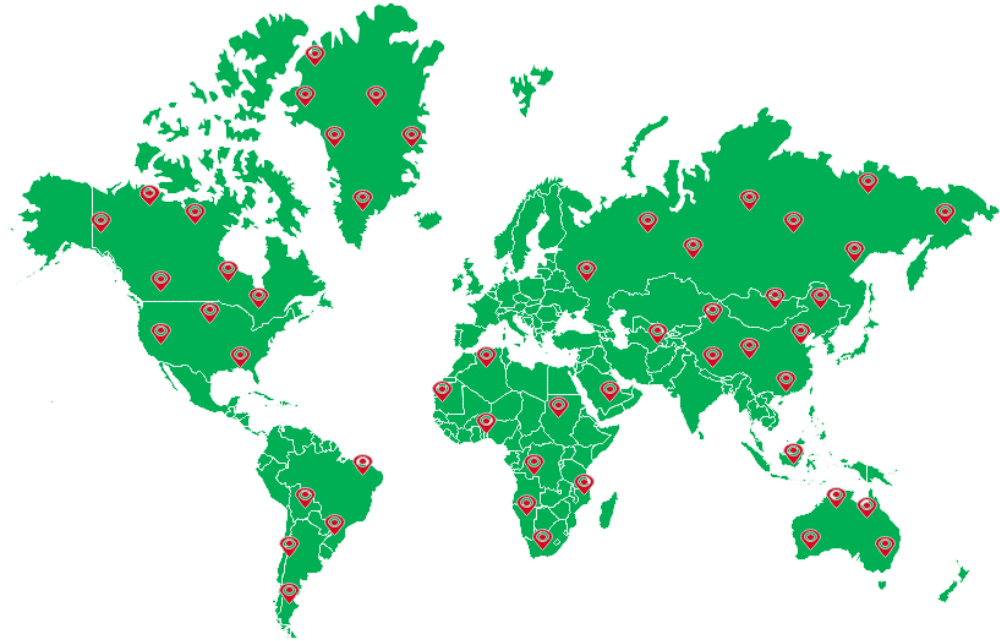
Figure 7. CLRS image acquisition area map; red marker points indicate images collected from the area.